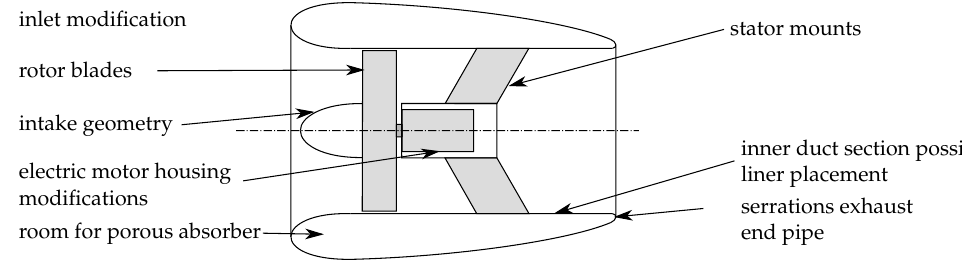
Table 2. Acoustic sources and characteristics in axial fans associated with the electric powertrain [5].